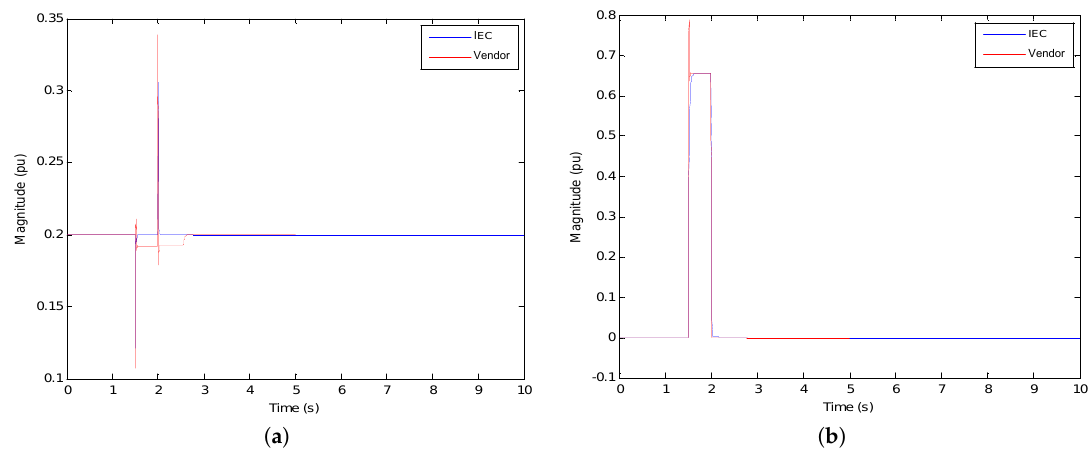
Figure 11. Type IVA results. Simulation scenario: p = 0.20 pu, u = 0.50 pu, t = 500 ms. ( a ) Active power, p ; and ( b ) reactive current, i q .